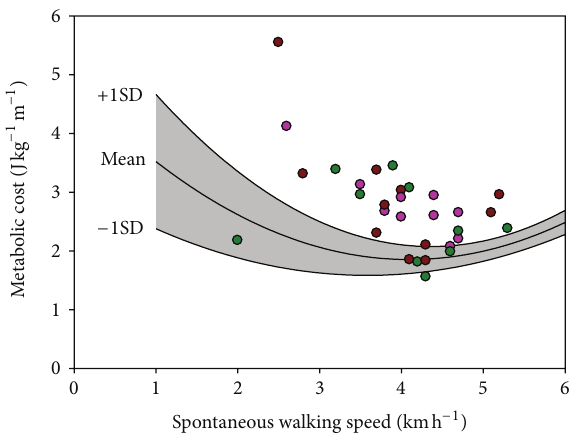
Figure 4: Net metabolic cost in 31 patients with haemophilia as a function of the total ROM at ankles, knees, and hips levels. The dynamic ROM of the hip, knee, and ankle was calculated as follows: ankle: A3-A2 (A3-maximum plantar flexion at pushoff; A2-maximum dorsiflexion in stance); knee: K4-K3 (K4-maximum flexion in swing; K3-maximum extension at preswing); hip: H2-H1 (H2-maximum extension in stance; H1-flexion at initial contact). The ROM of lower limb joints were calculated for both sides and then summed. 𝑟 = Pearson product moment